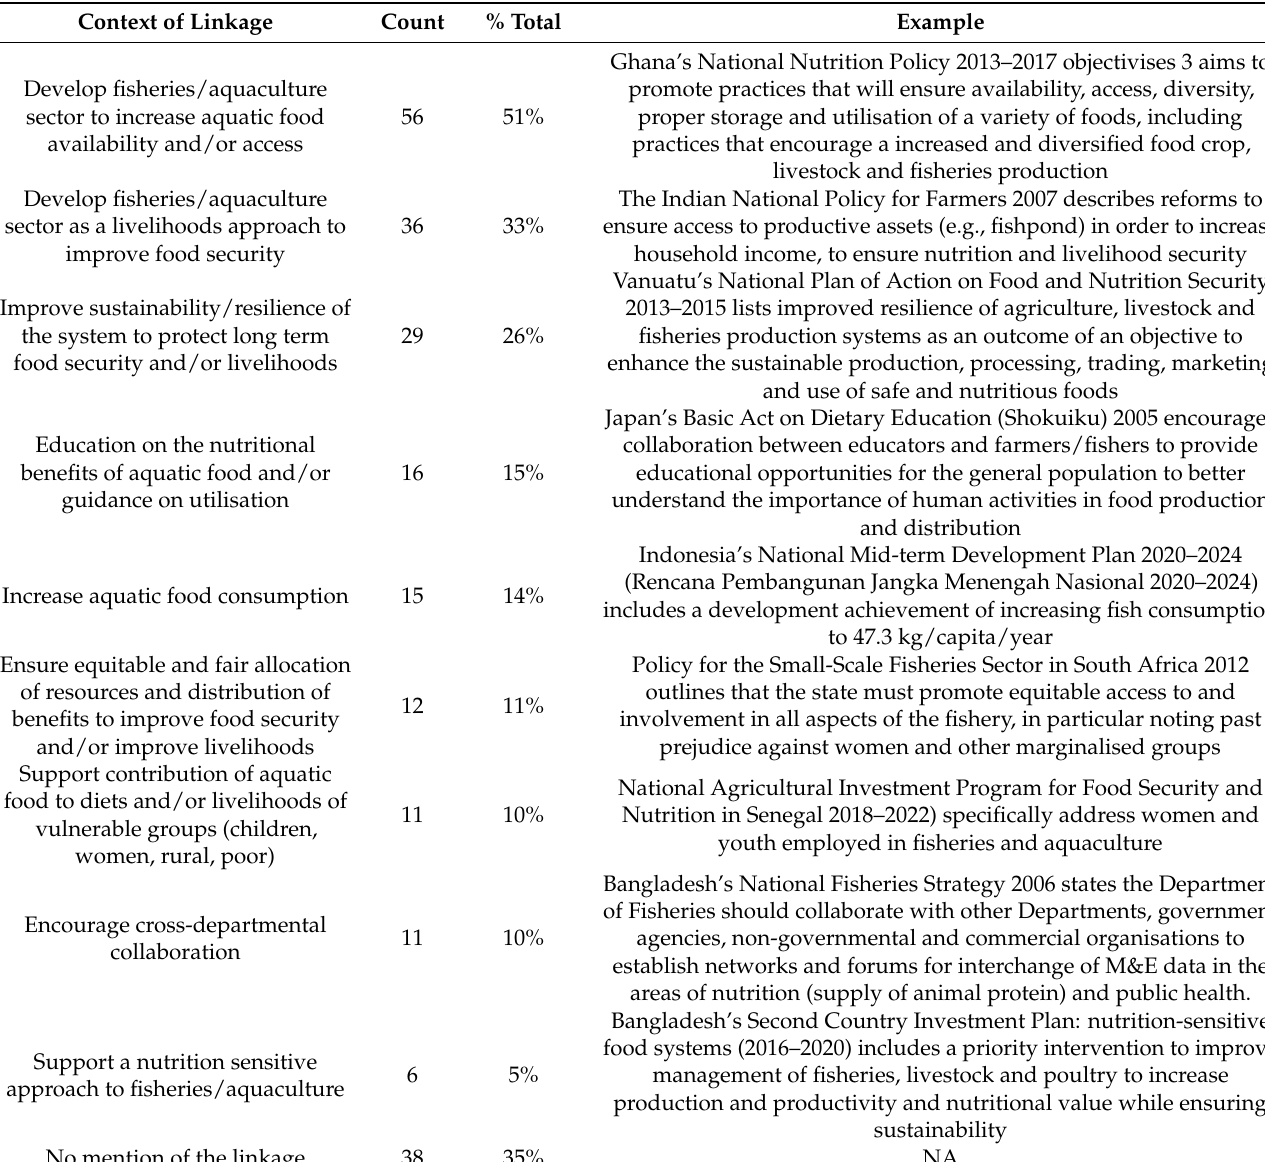
Table 5. Summary of linkages made between aquatic food and